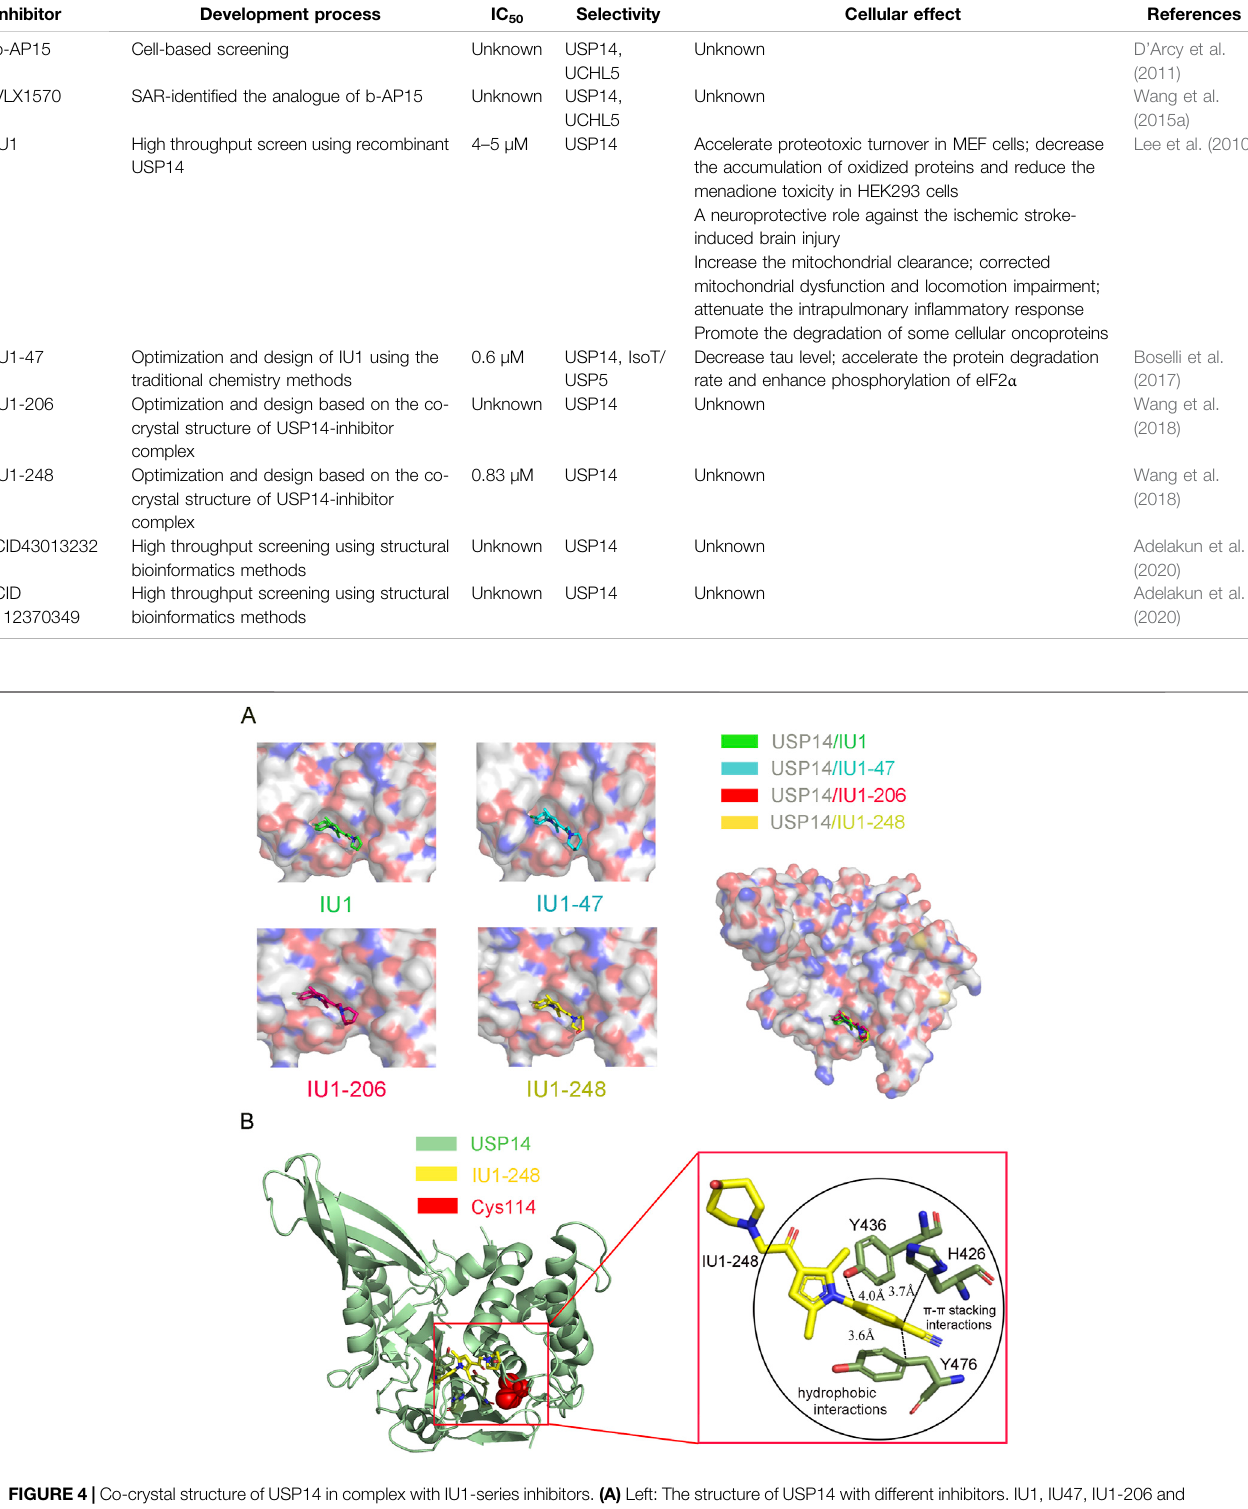
Frontiers in Pharmacology |